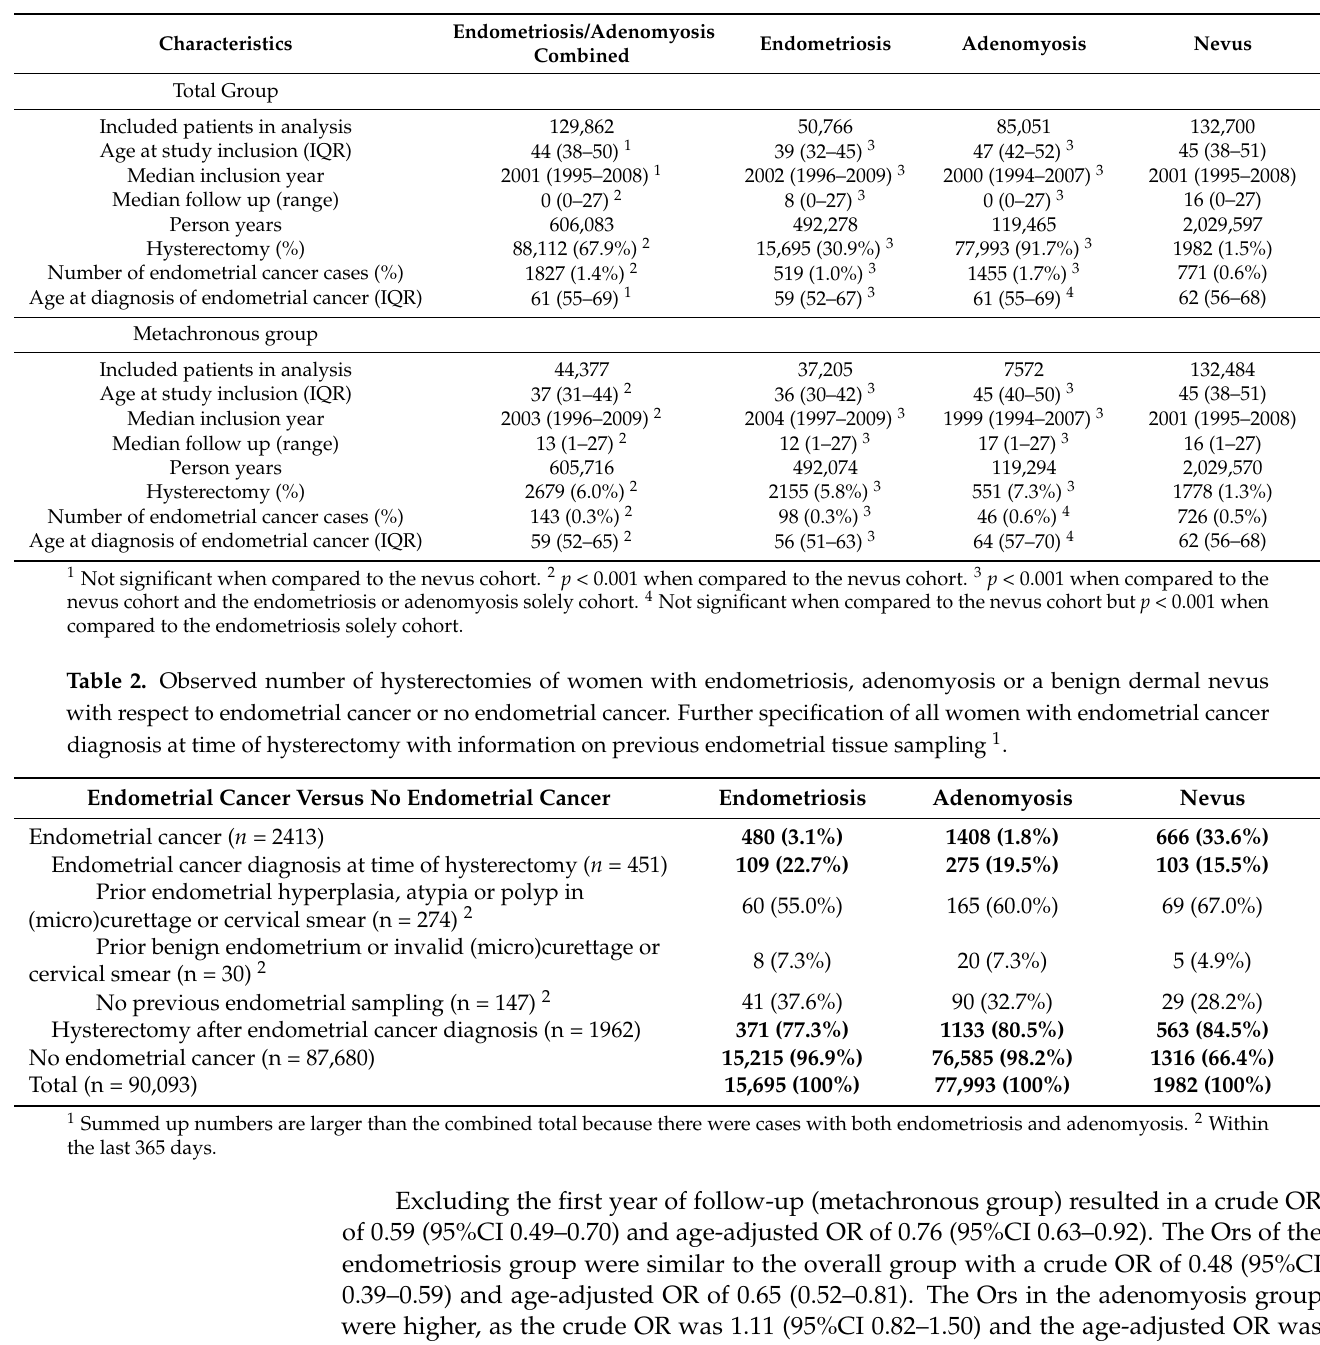
Table 1. Study characteristics—per endometriosis, adenomyosis and nevus group. Data are in numbers, percentages (%), years, median (IQR). Summed up numbers of endometriosis and adenomyosis are larger than the cases total because there were cases diagnosed with both endometriosis and adenomyosis. Metachronous group is defined as endometriosis, adenomyosis or nevus diagnosis at least a year before censoring date (autopsy, hysterectomy, or endometrial cancer).